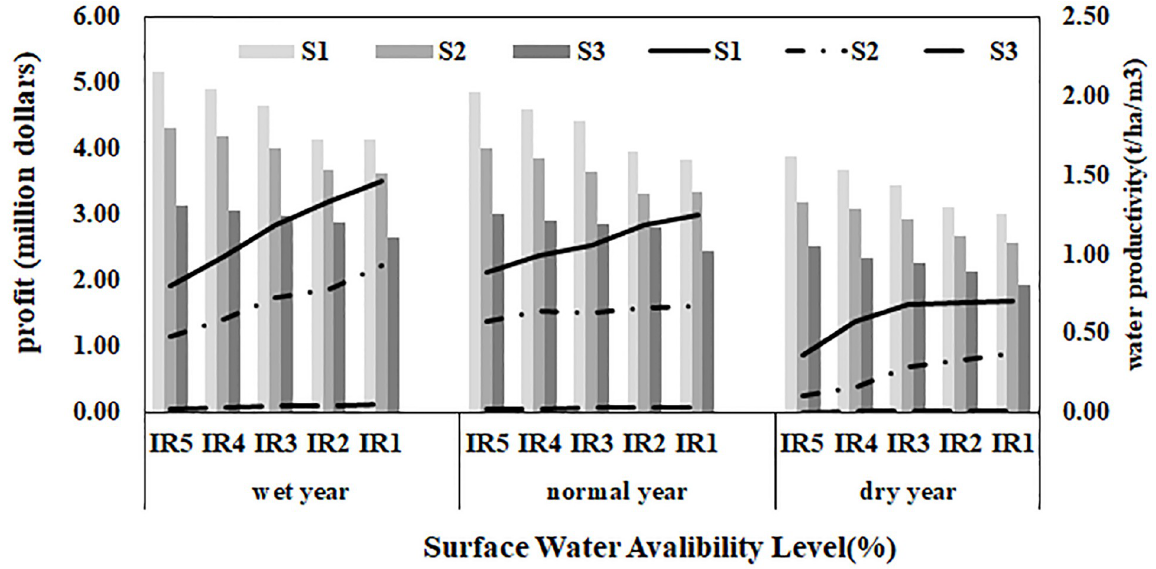
Fig 7. Profits and water productivity in wet, normal and dry years for soil types: S1, S2, S3.